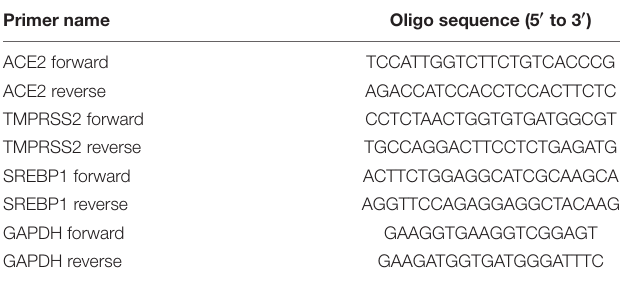
TABLE 2 | Forward and reverse primers of ACE2, TMPRSS22, SREBP1, and house keeping gene (GAPDH). Primer